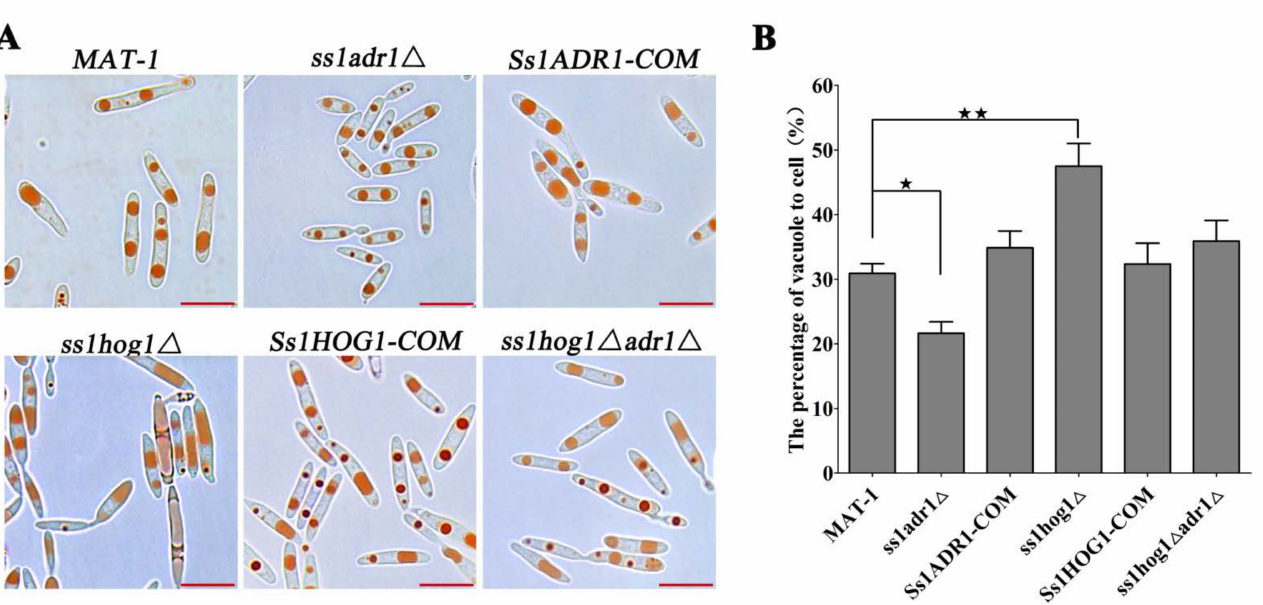
Figure 5. Effect of SsHog1 and SsAdr1 on vacuolar size. ( A ) Neutral Red staining in the MAT-1 , ss1adr1 ∆ , Ss1ADR1-COM , ss1hog1 ∆ , Ss1HOG1-COM , and ss1hog1 ∆ adr1 ∆ strains. The Neutral Red was mixed with the fresh haploid sporidia, and then 5 µ L of the sample was mounted on the slide and observed (Scale bar = 10 µ m). ( B ) The vacuole-to-cell size scaling ratio of MAT-1 , ss1adr1 ∆ , Ss1ADR1- COM , ss1hog1 ∆ , Ss1HOG1-COM , and ss1hog1 ∆ adr1 ∆ strains. Bar chart depicts statistical difference (cid:70) p (cid:70)(cid:70) p between the mean values ( < 0.05 and < 0.01). The sample was independently performed with three independent biological repeats. For each instance n > 50, samples were